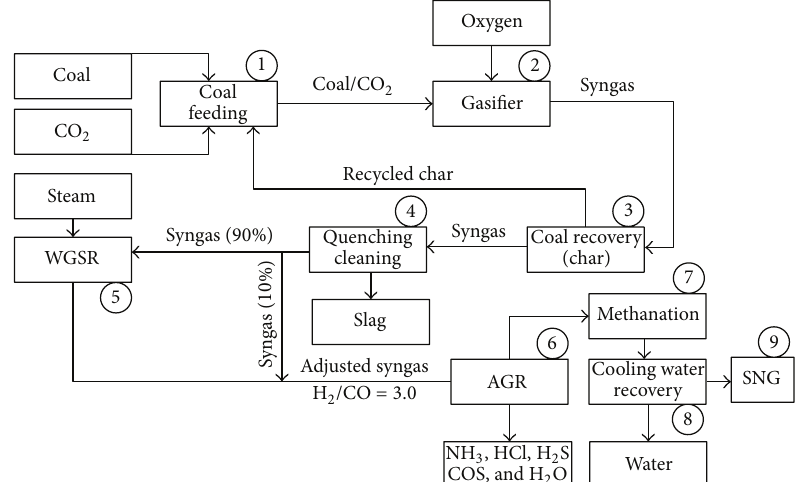
Figure 2: Process stages of SNG production via coal gasification using dry feeding